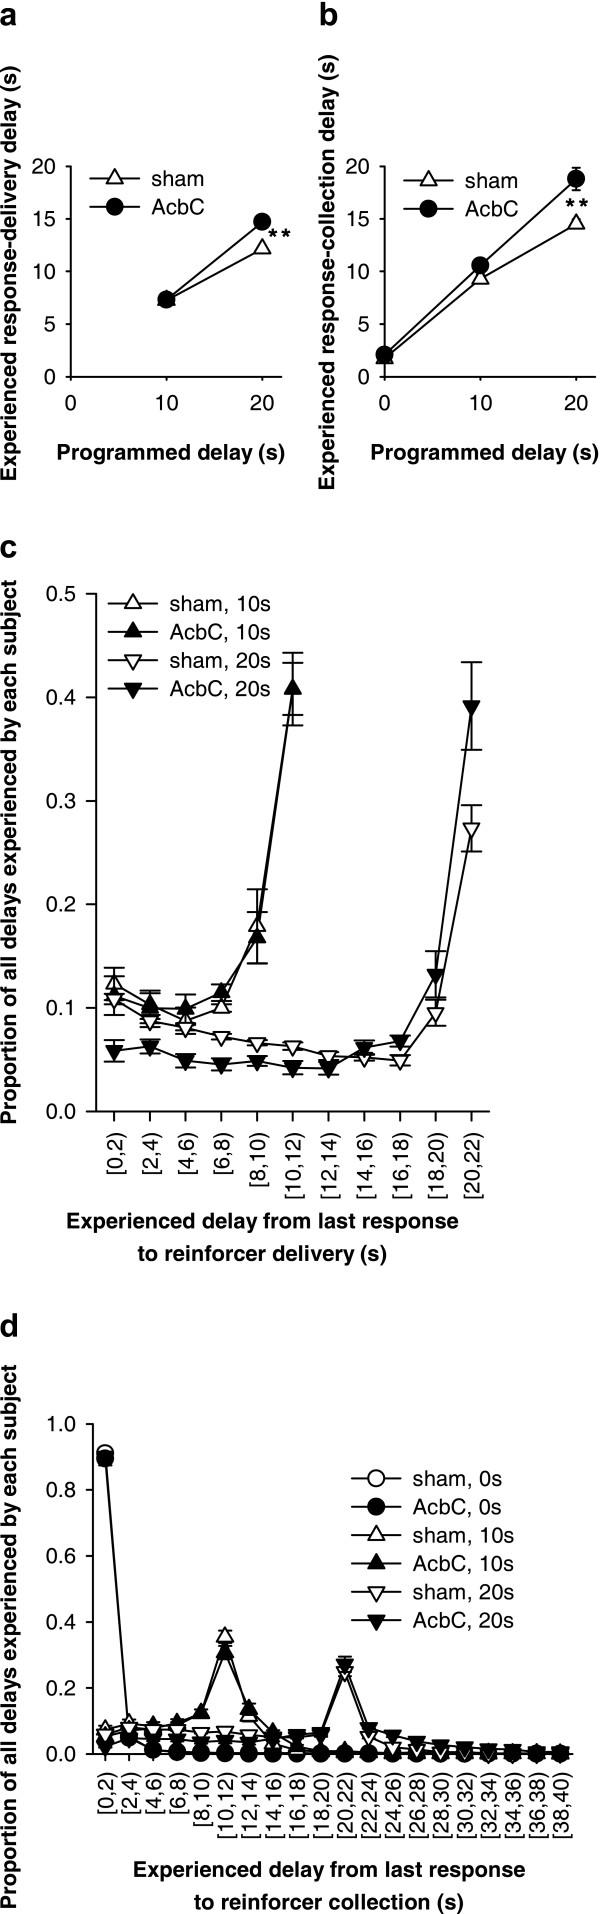
Programmed and experienced delays to reinforcement AcbC-lesioned rats experienced slightly longer response-delivery delays (the delay between the most recent active lever press and pellet delivery) than shams in the 20 s condition, and slightly longer response-collection delays (the delay between the most recent active lever press and pellet collection) in the 10 s and 20 s conditions. (a) Mean experienced response-delivery delays (one value calculated per subject). When the programmed delay was 0 s, reinforcers were delivered immediately so no data are shown. There was a lesion × programmed delay interaction (F1,26 = 12.0, p = .002): when the programmed delay was 10 s, the experienced delays did not differ between groups (F < 1, NS), but when the programmed delay was 20 s, AcbC-lesioned rats experienced longer response-delivery delays (one-way ANOVA, F1,13 = 19.0, ** p = .001). (b) Mean experienced response-collection delays (one value calculated per subject). There was a lesion × programmed delay interaction (F2,38 = 7.14, p = .002): AcbC-lesioned rats did not experience significantly different delays when the programmed delay was 0 s (F < 1, NS) or 10 s (F1,13 = 4.52, p = .053), but experienced significantly longer response-collection delays when the programmed delay was 20 s (F1,13 = 15.4, ** p = .002). (c) Distribution of experienced response-delivery delays. All experienced delays for a given subject were aggregated across all sessions, and the proportion falling into different 2 s ranges were calculated to give one value per range per subject; the graphs show means ± SEMs of these values. The interval notation '[a, b)' indicates that a given delay x falls in the range a ≤ x <b. There were no differences in the distribution of delays experienced by AcbC-lesioned and sham rats in the 10 s condition (lesion and lesion × range, Fs < 1, NS), but in the 20 s condition AcbC-lesioned rats experienced slightly fewer short delays and slightly more long delays (lesion × range, F2.1,27.7 = 6.60,  = .213, p = .004). (d) Distribution of experienced response-collection delays, displayed in the same manner as (c). There were no differences in the distribution of delays experienced by AcbC-lesioned and sham rats in the 0 s condition (lesion and lesion × range, Fs < 1, NS). In the 10 s condition, AcbC-lesioned rats experienced a slightly higher proportion of long response-collection delays and a slightly lower proportion of short response-collection delays (lesion, F1,13 = 6.36, p = .036, though the lesion × range interaction was not significant, F2.6,34.3 = 1.74,  = .139, p = .181). Similarly, in the 20 s condition, AcbC-lesioned rats experienced a slightly higher proportion of long response-collection delays and a slightly lower proportion of short response-collection delays than shams (lesion × range, F4.2,54.8 = 6.65,  = .222, p < .001).